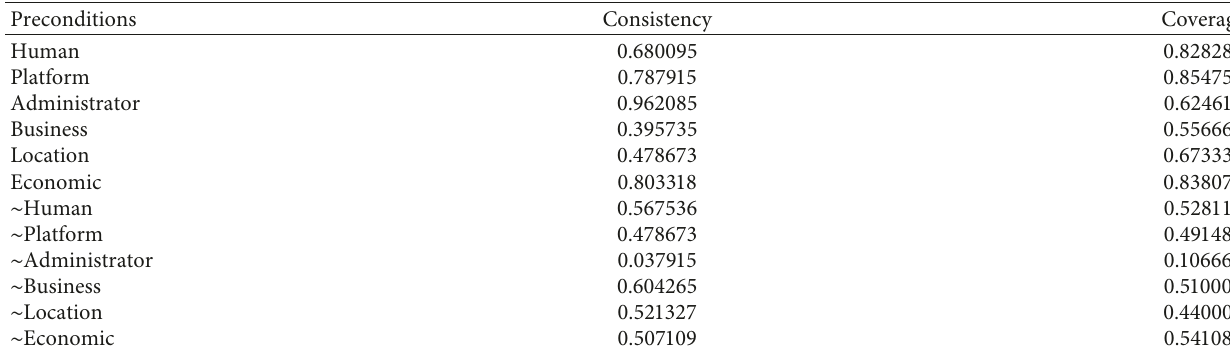
Table 3: Analysis result of necessary